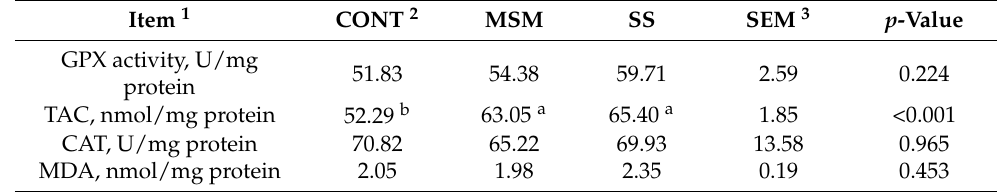
Table 8. Effects of dietary sulfur on oxidative stress markers of liver in laying hens ( n = 8). Item 1 CONT 2